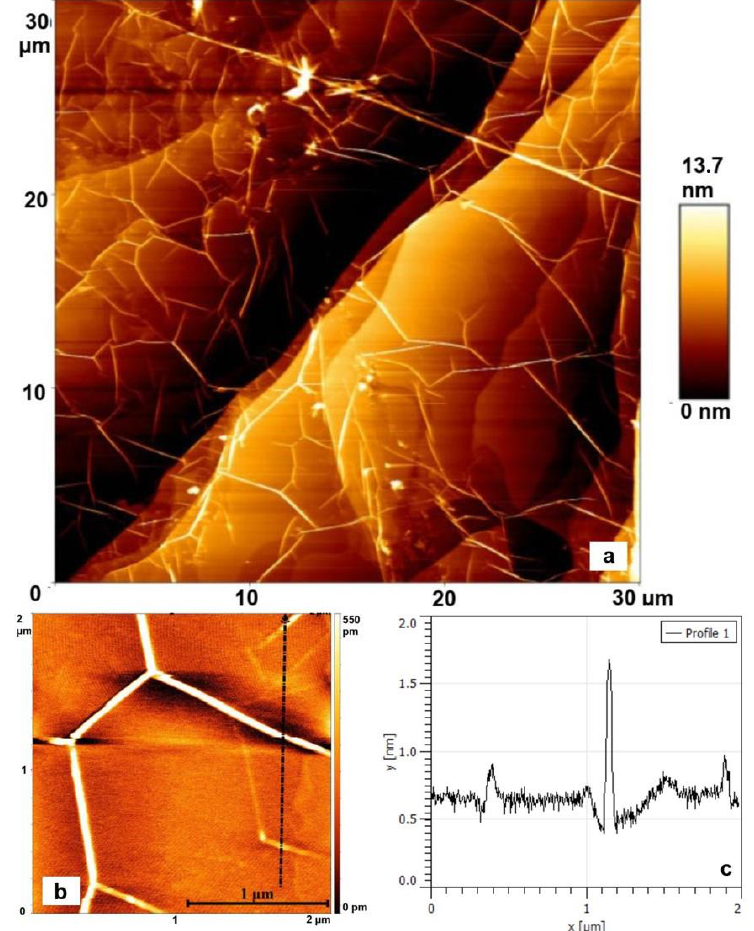
Figure 3. ( a ) 30 × 30 µm 2 of the graphitized surface of sample StGr-1. Visible are bigger steps of about 12 nm height where they coalesce, running diagonally from bottom left to top-right of the picture. On top of the surface, bright lines that create a pseudo hexagonal network. They are taken as wrinkles on the surface; ( b ) 2.1 × 2.1 µm 2 close-up of these bright lines. The dashed black arrow indicates the trace of the height-profile depicted on the right, ( c ); ( c ) 2 µm long profile across the surface. The trace of the profile-line can be viewed on the left ( b ). The elevated lines are seen as borderlines or overlapping regions of two adjacent hexagonal flakes of graphene — hence the elevation. Here it is interpreted that the ele- vated borderline of the lower graphene network deforms the topmost thin flakes grow- ing above them. This causes the border zone to be traceable through the topmost layer. The stiff, yet bendable graphene on top smooths the surface expression. This is the reason